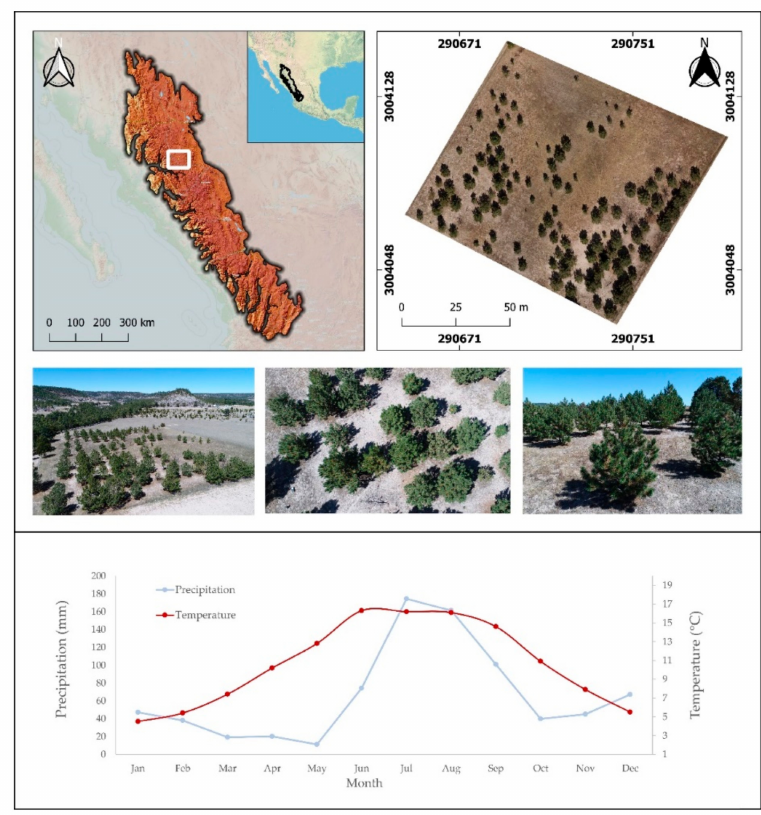
Figure 1. View of clonal orchard of Pinus arizonica Engelm. and climatogram in the Papajichi ejido, state of Chihuahua, north of